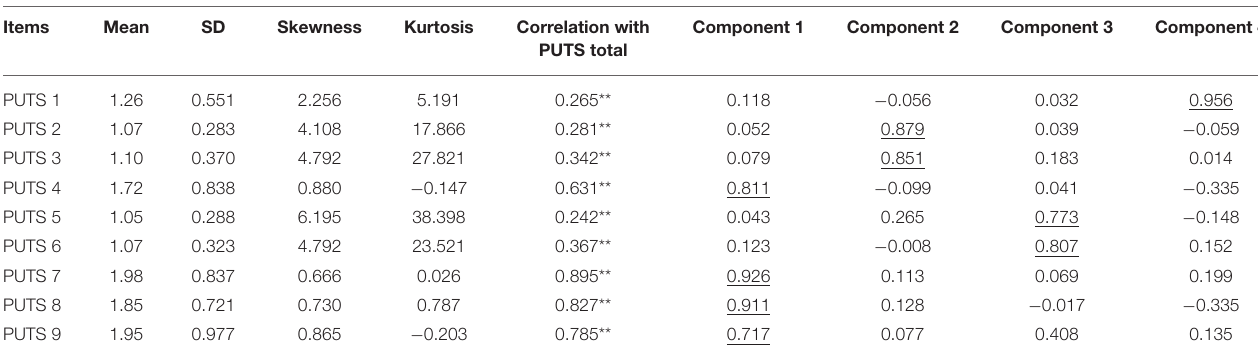
TABLE 2 | Correlation between the Items Scores and Total PUTS Scores and Results of